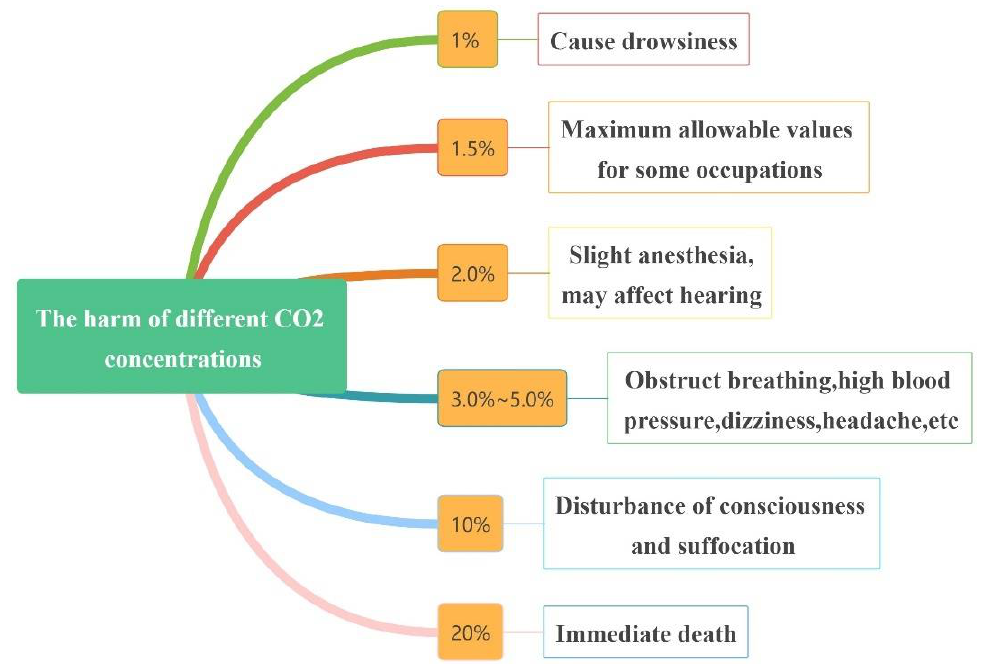
Figure 9. Hazards of different CO 2 concentrations to human health. Reproduced with permission from [101], Elsevier, 2020.